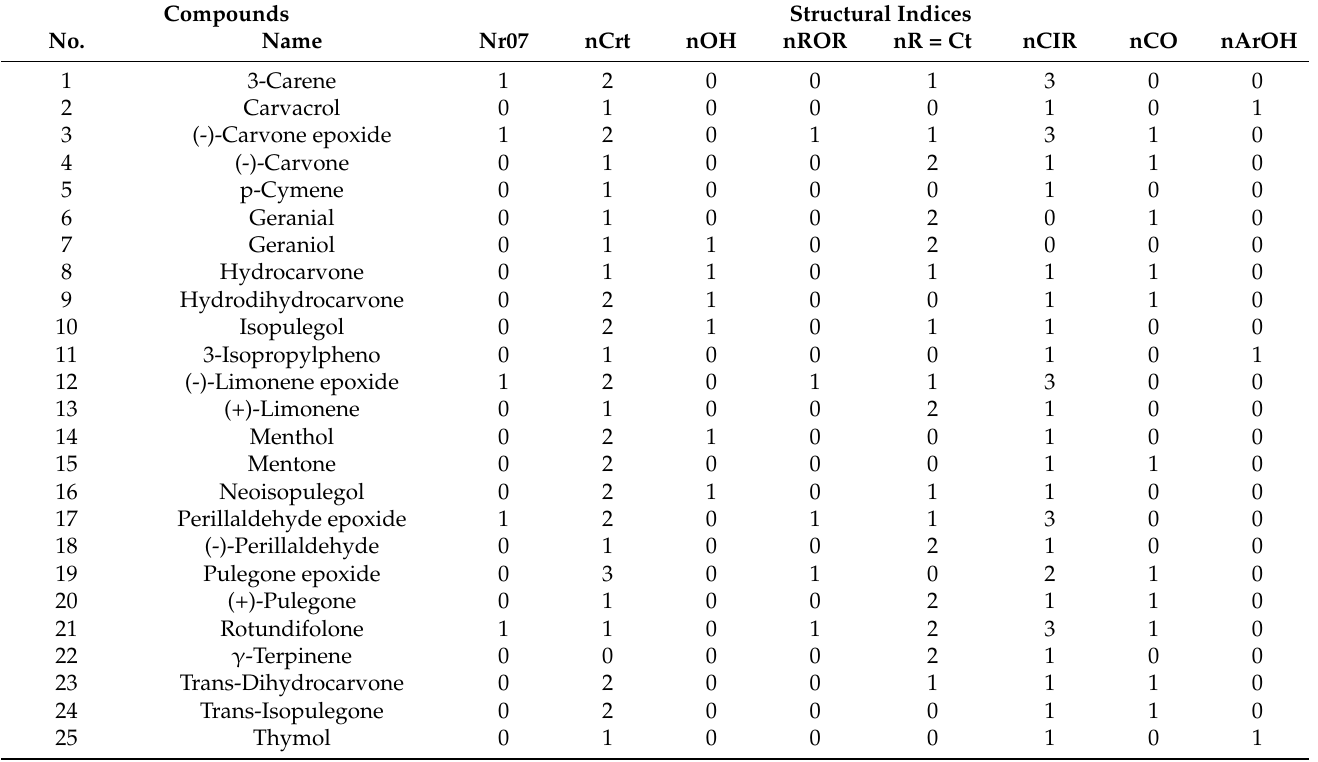
Table 3. Structural parameters used to derive QSAR models.